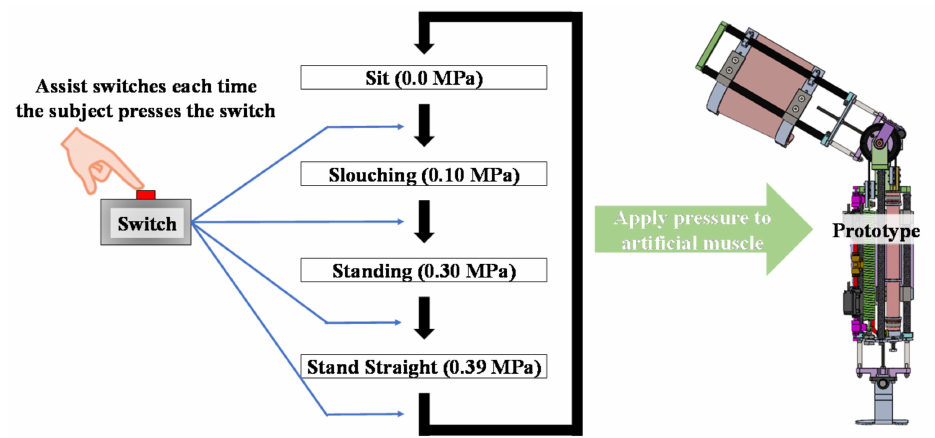
Figure 11. How to switch the assist mode with a